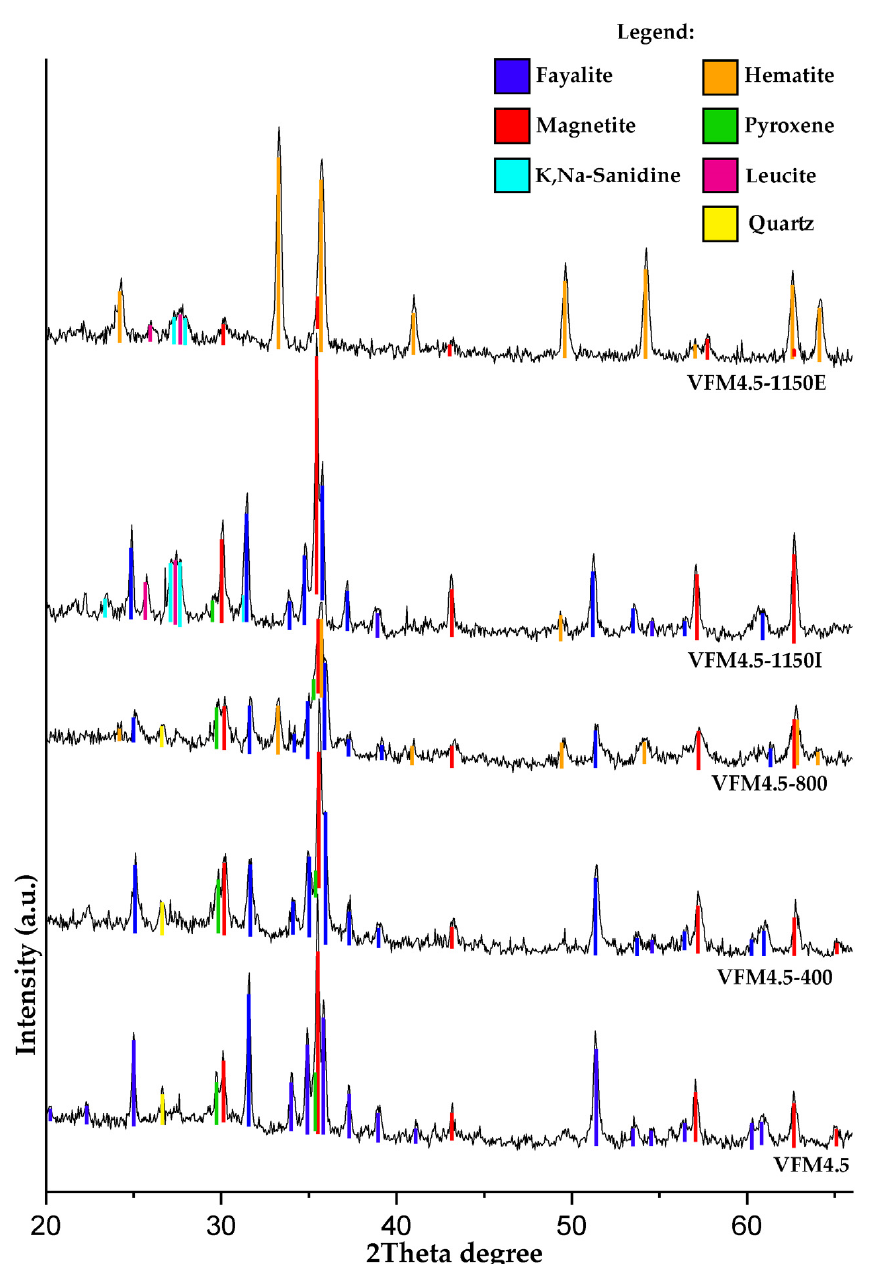
Figure 5. Powder XRD analysis of geopolymer series VFM4.5 exposed to temperatures from 400 to 1150 °C. Suffix: E—sample from external part of the specimen, I—sample from internal part of the specimen.